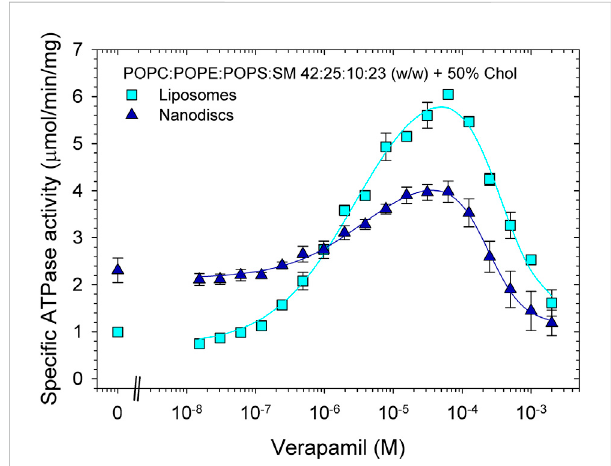
FIGURE 6 Effects of reconstitution on the verapamil-stimulation of ATPase inlipidsmimickingplasmamembranes.Puri fi edPgpwasreconstituted into liposomes and lipid nanodiscs. ATPase activity was measured as described in Experimental Procedures. Data points represent the mean ± SEM ( n = 3). In liposomes, more than 84% of Pgp ’ s NBDs were accessible, see Fig. S7.